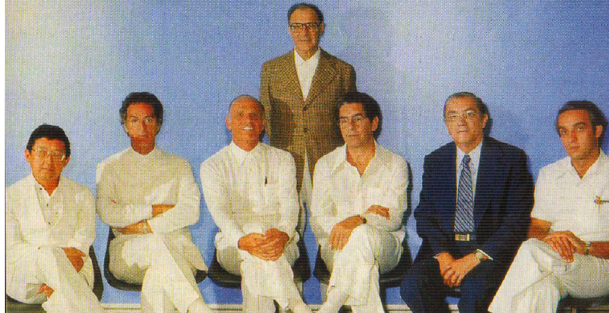
Fig. 3 – In the Board of Directors room at Incor (Euclydes J. Zerbini standing; seated from left to right, Seigo Tsuzuki, Director of Bioengineering; Geraldo Verginelli, Assistant Professor; João Tranchesi, Chief of Electrocardiogram; Radi Macruz, Assistant Professor; Fulvio Pilleggi, Full Professor; and Noedir Stolf, Assistant Professor).